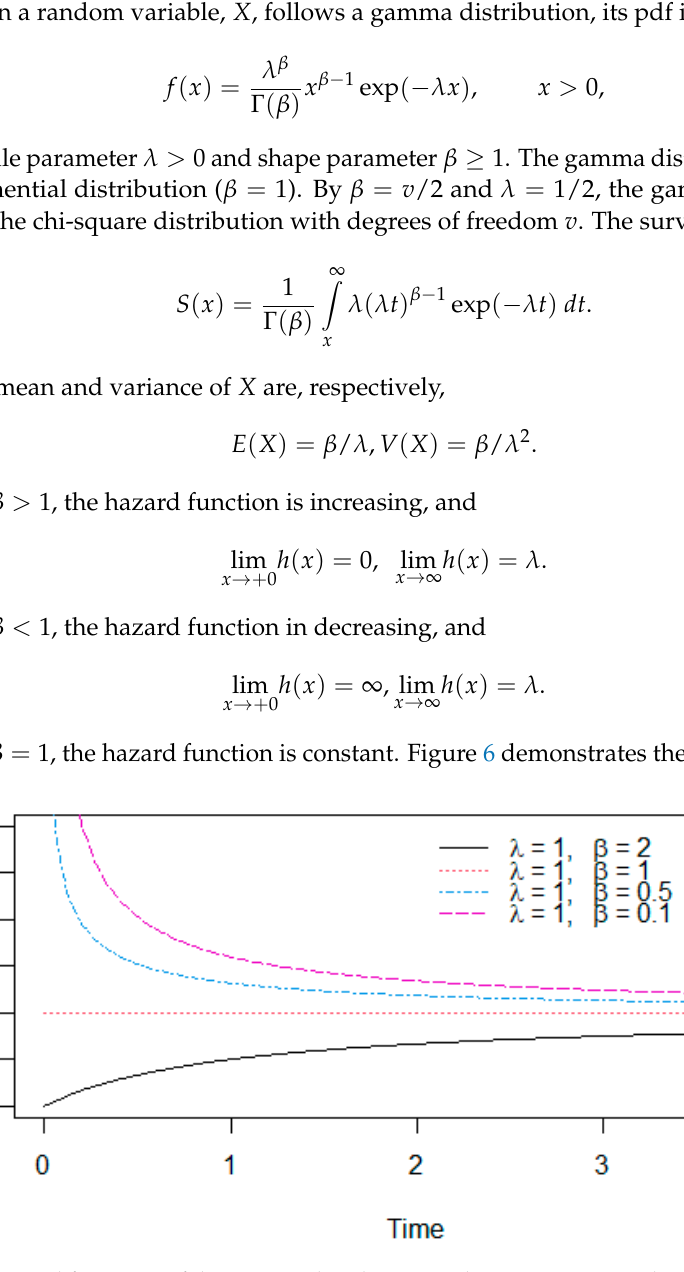
Figure 6. Hazard functions of the gamma distribution with parameters 𝜆 and 𝛽 .